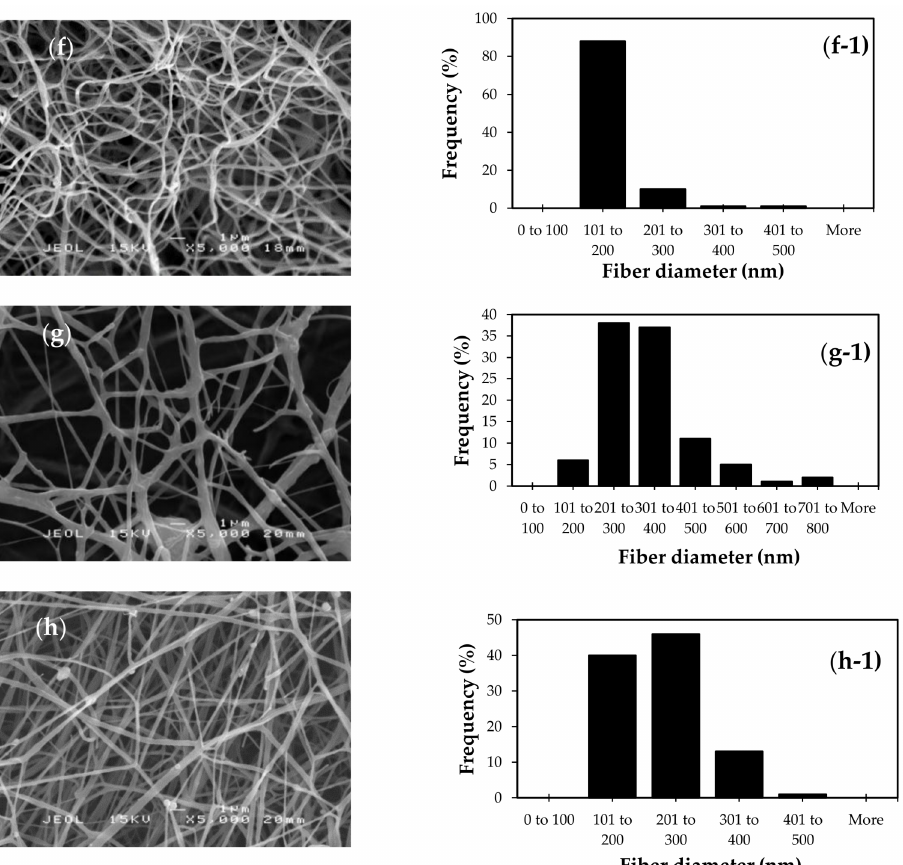
Figure 3. SEM images ( a – h ) and the corresponding fiber diameter distribution (( a-1 )–( h-1 )) of CMSP / PEO nanofibers at di ff erent concentration of CMSP to PEO solution and ratio of CMSP to PEO ( a ) 4% (ratio 1:1), ( b ) 4% (ratio 1:3), ( c ) 6% (ratio 1:1), ( d ) 6% (ratio 1:3), ( e ) 8% (ratio 1:1), ( f ) 8% (ratio 1:3), ( g ) 10% (ratio 1:1) and ( h ) 10% (ratio 1:3). Electrospinning parameters were kept constant at 20 kV for applied voltage, 15 cm of tip-to-collector distance and 0.8 mL / h for flow